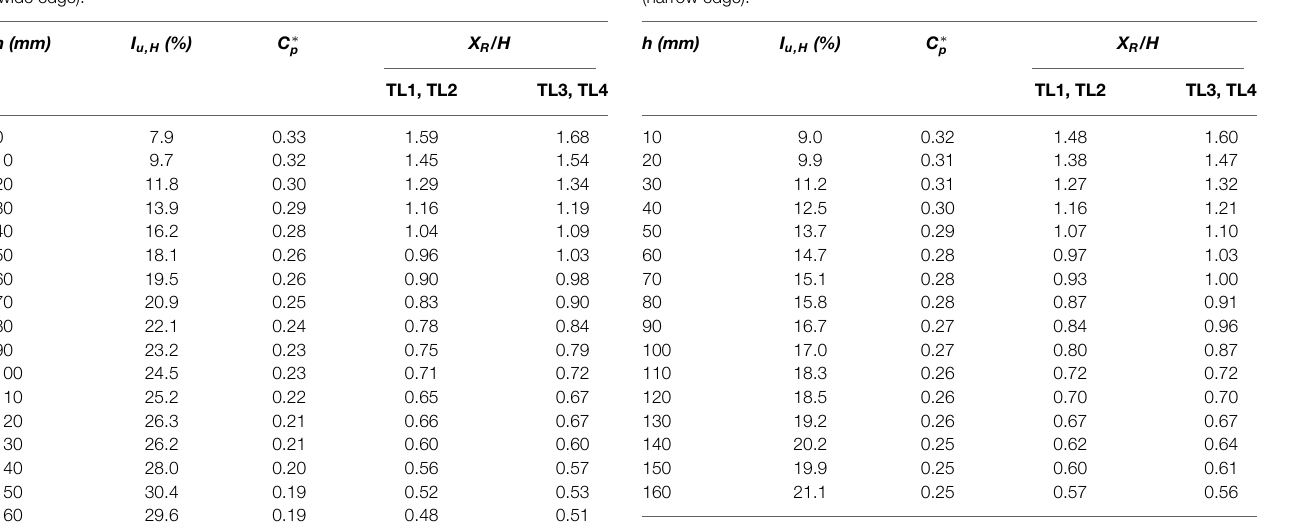
TABLE 2 | Reduced pressure coefficient and mean reattachment length estimates (wide edge).